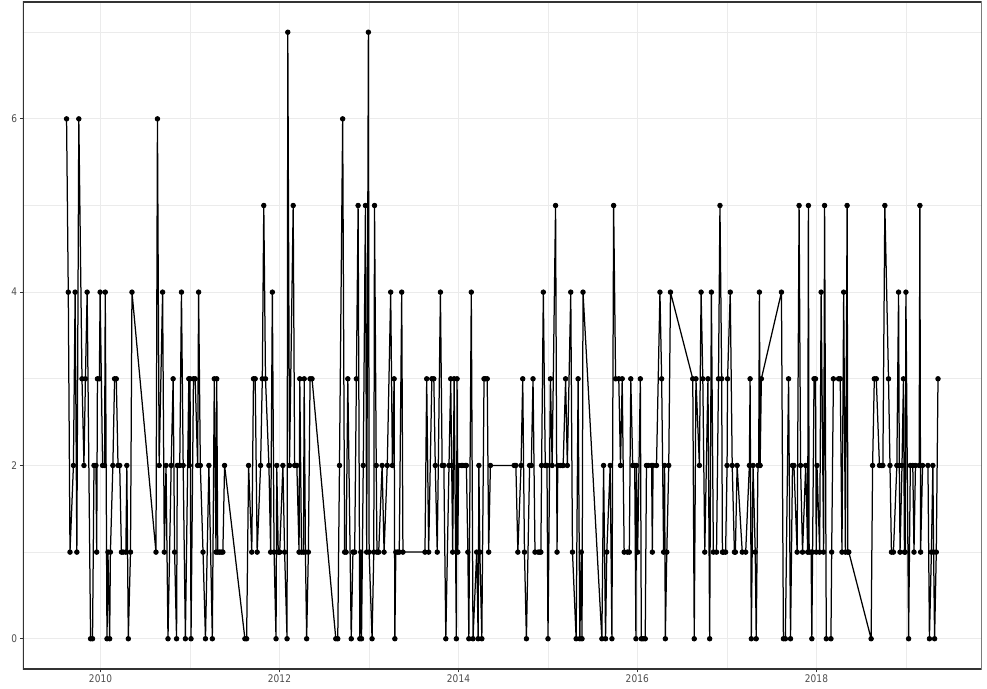
Figure 5. Time series of scored goals by Arsenal in English Premier League between Season 2009–2010 and Season